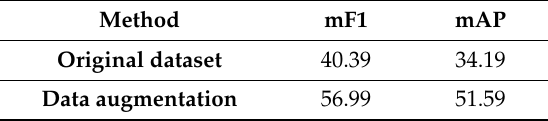
Table 7. Verification result of using Hurricane Irma dataset.